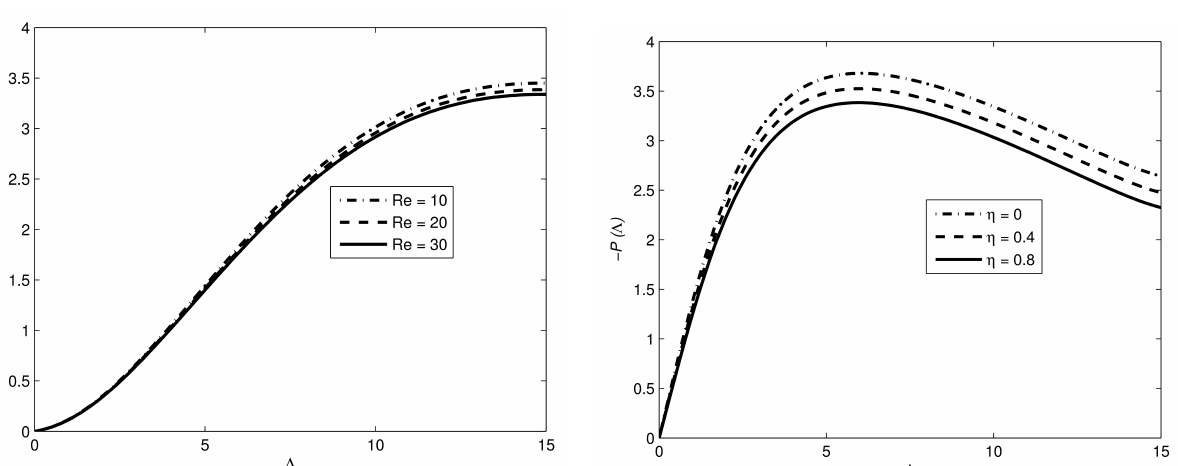
Figure 16: Effect of ζ on − P ( Λ ) keeping η = 0.2 , Pr = 6.8 , Br = 1 , Re = 2950 , C 1 = C 2 = C 3 = 50